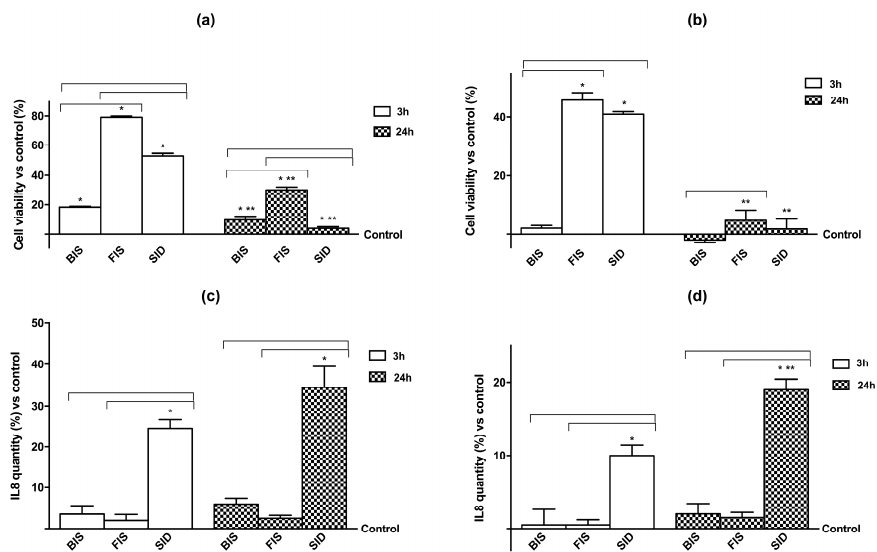
Figure 2. Cell viability ( a , b ) and interleukin 8 (IL-8) concentration ( c , d ) at 3 h and 24 h measured on GTL-16 and Caco-2 cells treated with different iron formulations. In A and B cell viability, measured by 3-(4,5-Dimethylthiazol-2-yl)-2,5-Diphenyltetrazolium Bromide (MTT) assay, and in C and D IL-8 concentration, measured by ELISA kit, on both cell types were reported. Data are expressed as means ± SD (% vs. control) of four independent experiments for each cell type. FIS = Fisioeme ® . * p < 0.05 vs. control (reported as line); ** p < 0.05 vs. correspondent column at different time; bars p < 0.05 among different treatments at the same time.